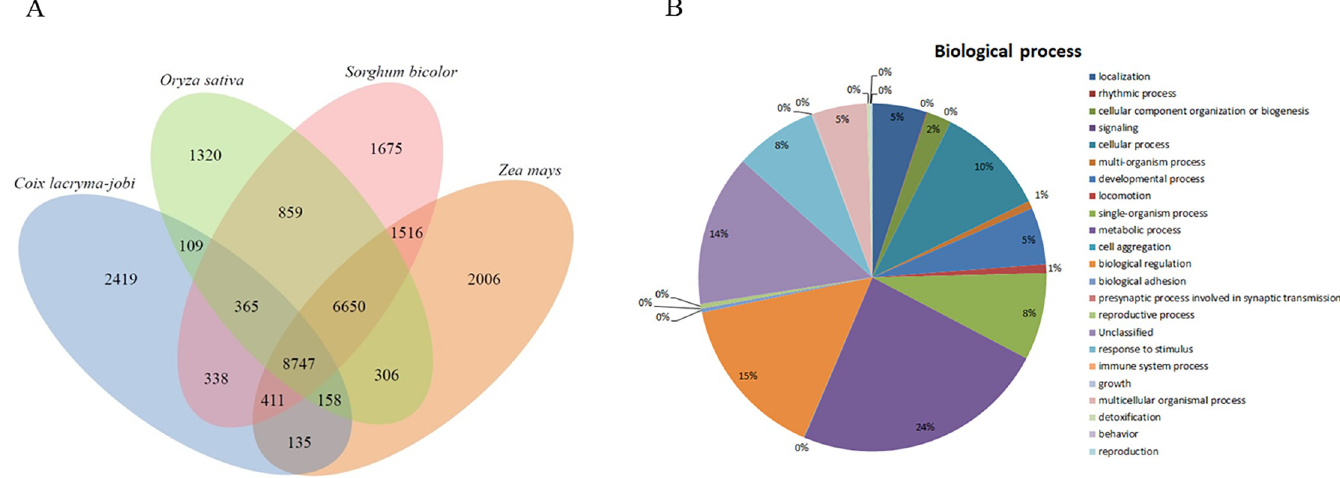
Fig 2. The distribution of 27,014 gene families among four monocot genomes. (A) Shared and unique gene families in C . lacryma-jobi , O . sativa , S . bicolor , and Z . mays . (B) GO analysis of the distribution of unique gene families of C . lacryma-jobi in various biological processes.